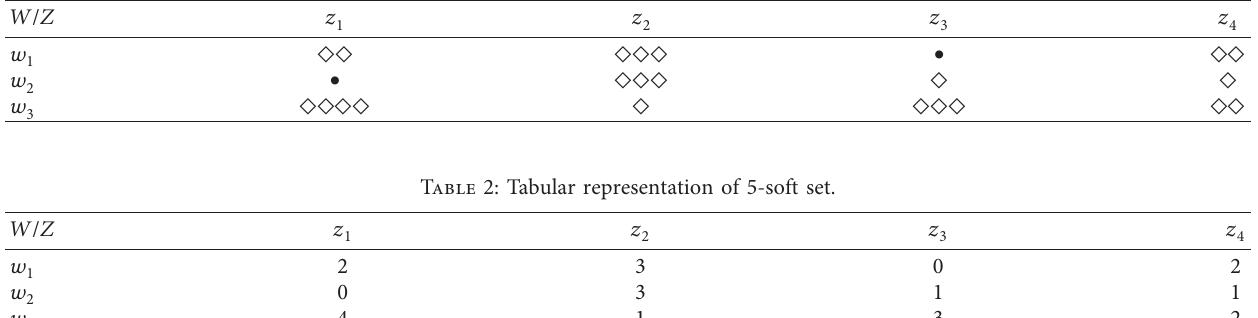
Table 1: Evaluation data provided by the experts.